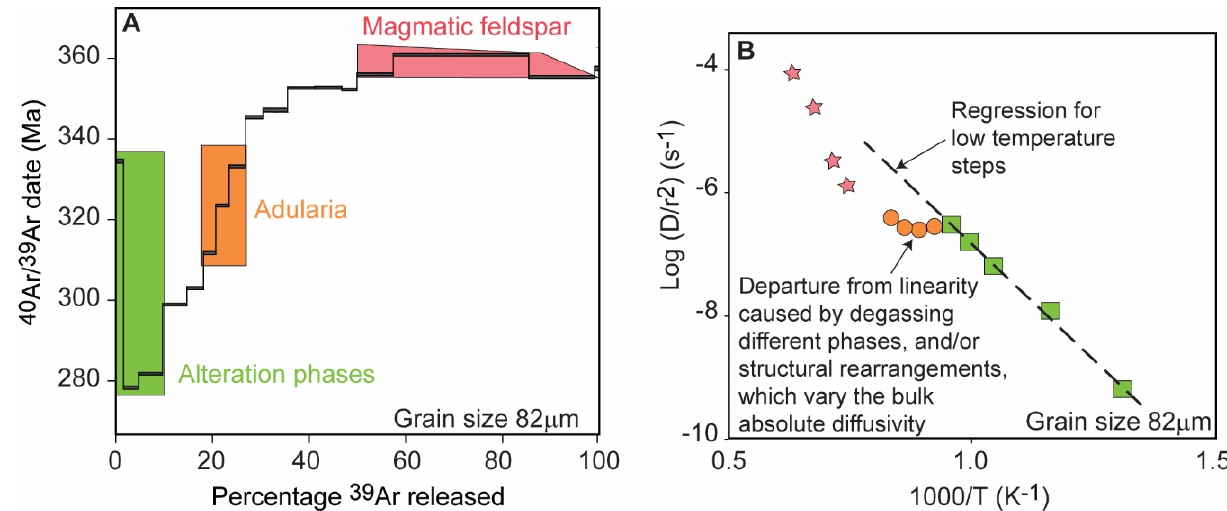
Figure 3. ( A ) Staircase-shaped age spectrum for alkali feldspar extracted from the Chain of Ponds Pluton (New England, USA), highlighting the contribution of gas derived from alteration phases, adularia and pristine magmatic alkali feldspar. The relative contributions suggest the staircase topology is a consequence of the co-existence of heterochemical phases with different apparent ages (data and interpretation from [71]). ( B ) Arrhenius data corresponding to the age spectrum in ( A ), which shows that (i) variations from linearity are due to degassing of different retrogressed phases and variations in diffusivity (D; as opposed to solely being due to variations in diffusion length scale), and (ii) activation energy determinations derived from regressing the low temperature steps (determined from the gradient) relate to alteration phases, and not pristine, magmatic feldspar. Colours relate to the same phases that are labelled in ( A ). Data and graphs are from Chafe et al. (2014) [71]. The inferences about magmatic feldspar, adularia and alteration phases were made by combining EPMA, CL images and the argon isotope data.